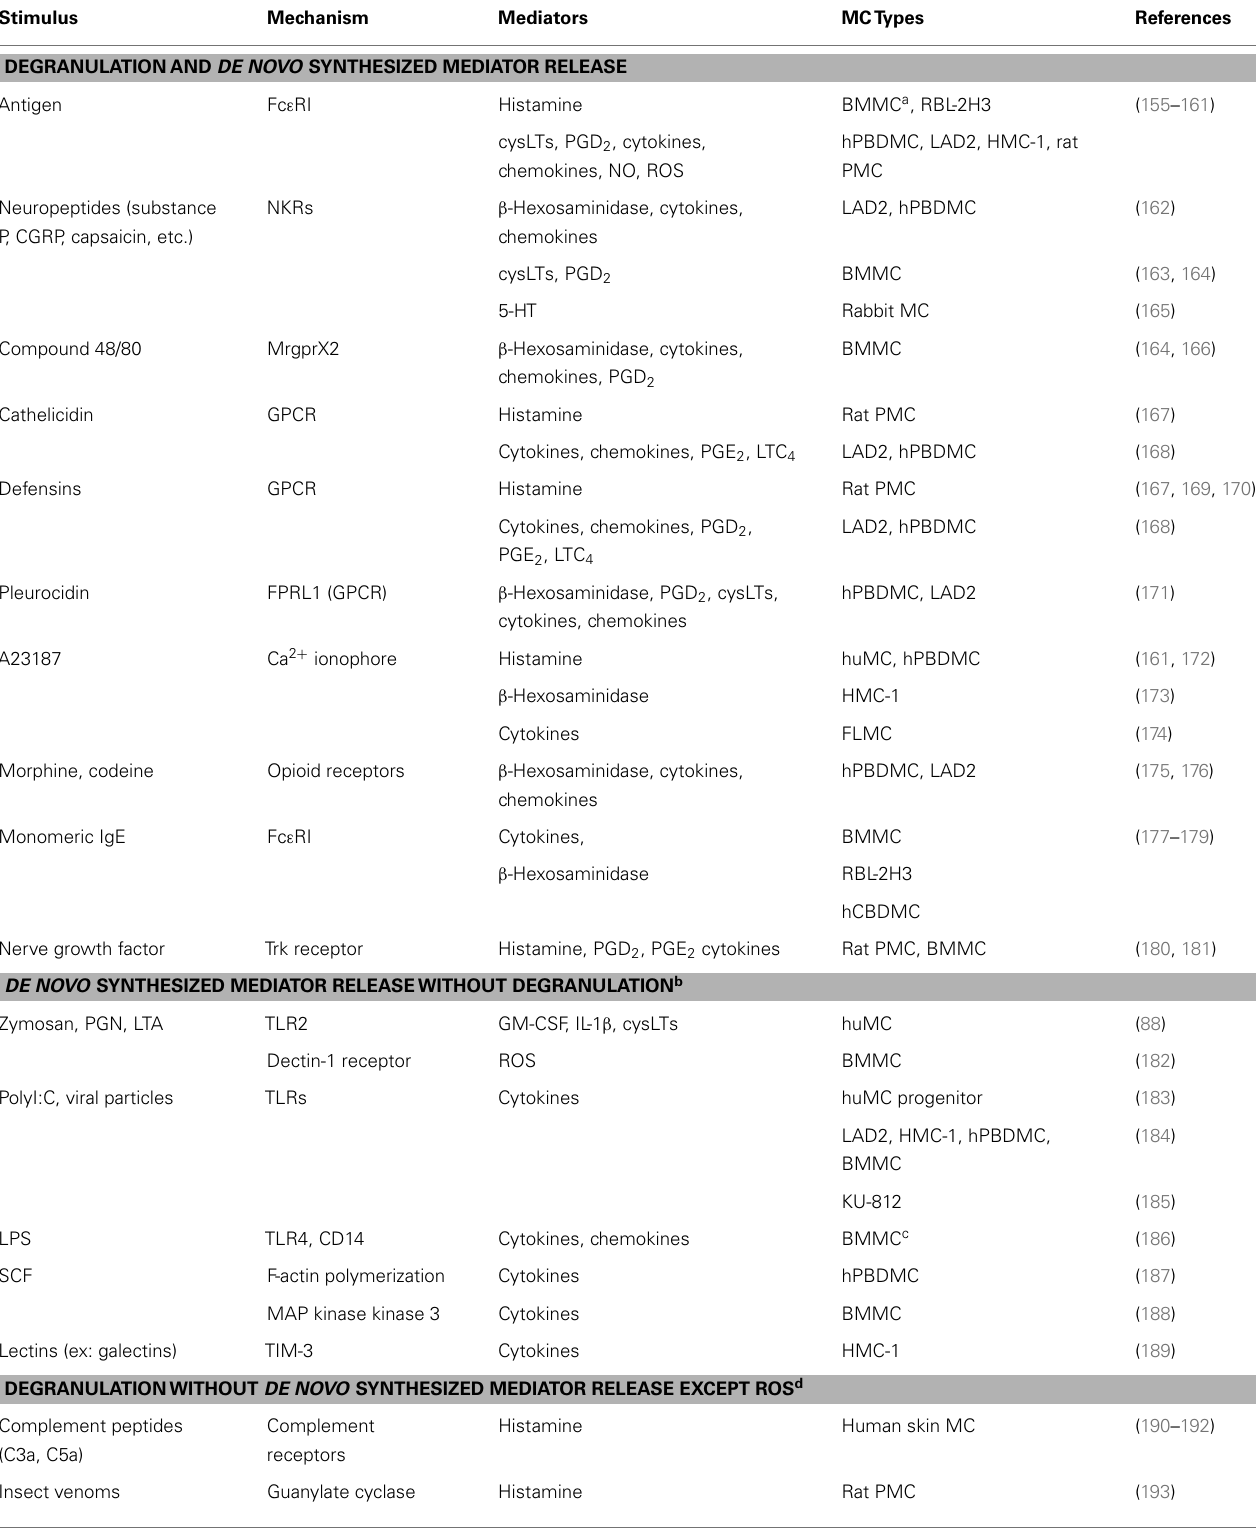
Table 2 | Stimuli-selective mediator release from mast cells (some representative examples)